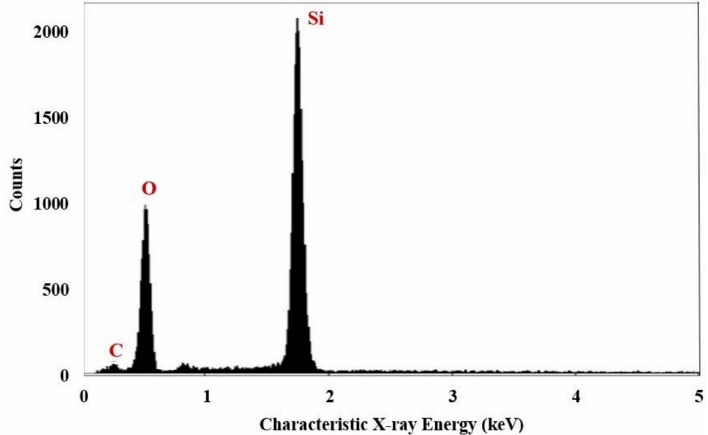
Figure 3. Energy dispersive X-ray spectroscope (EDX) spectrum analysis of superhydrophobic aluminum surface with Coating